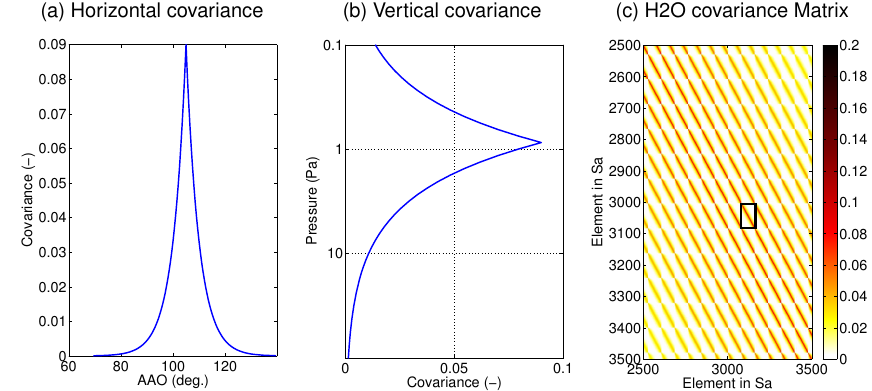
Figure 3. (a) Vertical and (b) horizontal elements of the covariance matrix for H 2 O at AAO 0.09Pa and 105 ◦ . (c) Elements of the total covariance matrix for water vapour. The black square indicates a single covariance block, i.e. covariance between altitudes at the same AAO.